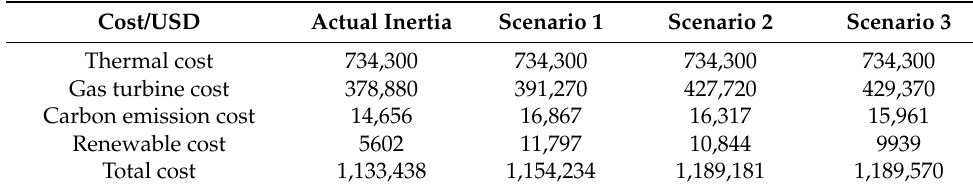
Table 2. Results for intraday scheduling costs.